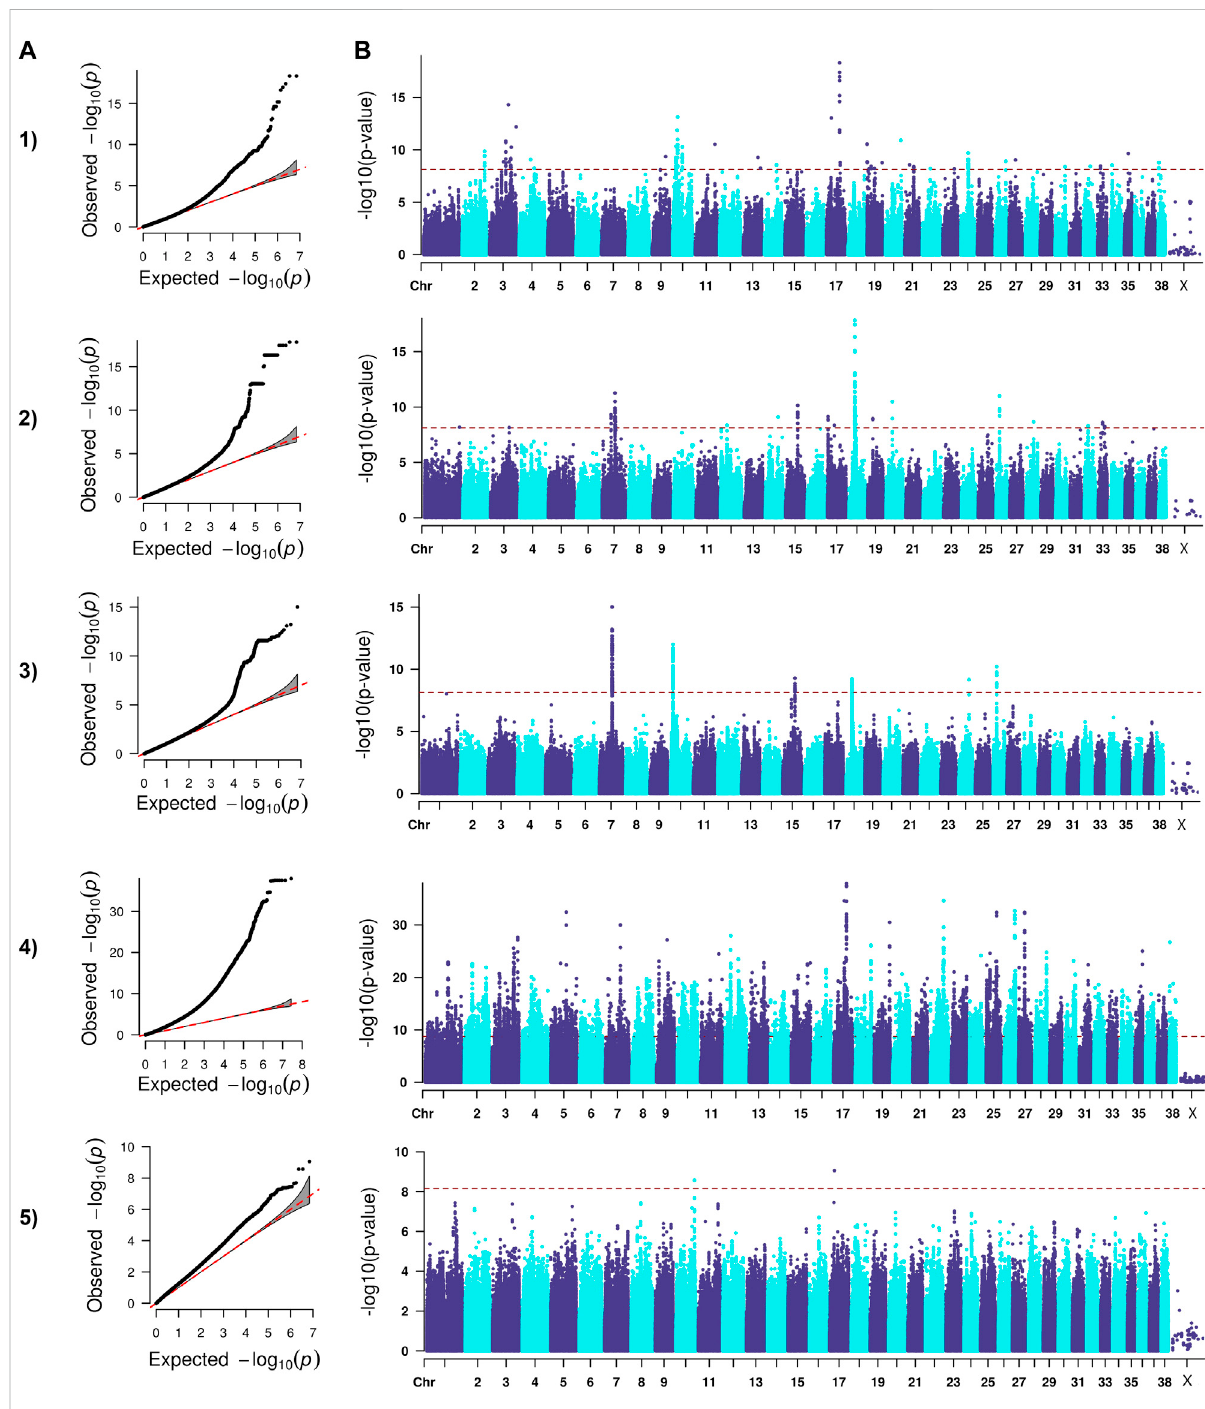
FIGURE 3 QQ (A) and Manhattan (B) plots. Comparison of four models for performing across-breed genome-wide association study using breed phenotypes for hospital hip dysplasia. 1) Linear mixed model, λ = 0.96, 195 signi fi cant single-nucleotide polymorphisms (SNPs) with the strongest associations on chromosome 3, 10, 11, 17, 19, and 20 ( p < 7.12E-9). 2) Stringent binary case-control model, λ = 1.04, 364 signi fi cant SNPs with the strongestassociationsonchromosomes 7,15,18,20,and26( p < 7.26.E-9).3)Lenient binarycase-controlmodel, λ =1.00,376signi fi cantSNPs on chromosomes 7, 10, 15, 18, 24, and 26 ( p < 7.13E-9). 4) Haplotype-based model, λ = 1.97, 18,895 signi fi cant SNPs with the strongest associations on chromosomes 5, 7, 12, 17, 19, 22, 25, 26, and 27 ( p < 1.82E-9). 5) Weighted least squares model, λ = 1.54, 3 signi fi cant SNPs on chromosomes 10 and 17 met Bonferroni signi fi cance cutoff ( p <